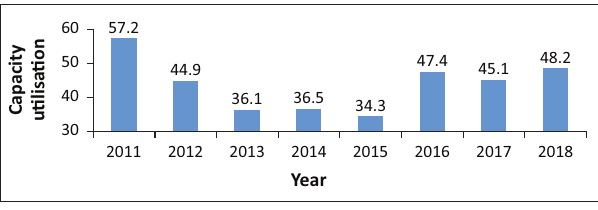
FIGURE 1: Manufacturing sector’s capacity utilisation.